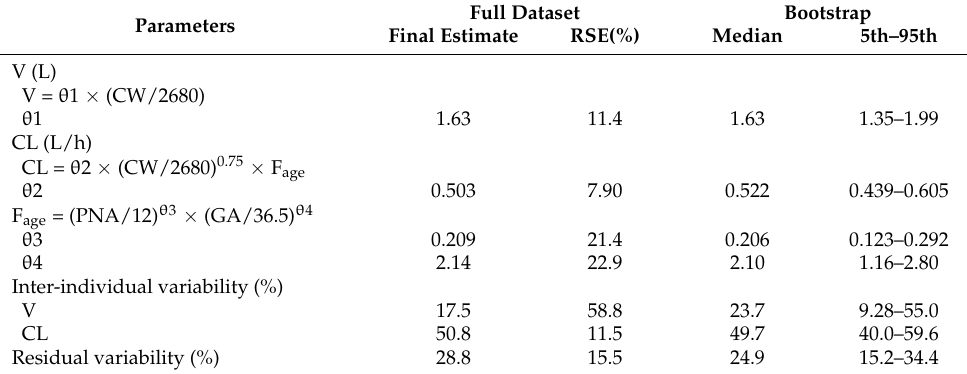
Table 2. PopPK parameters and bootstrap results.